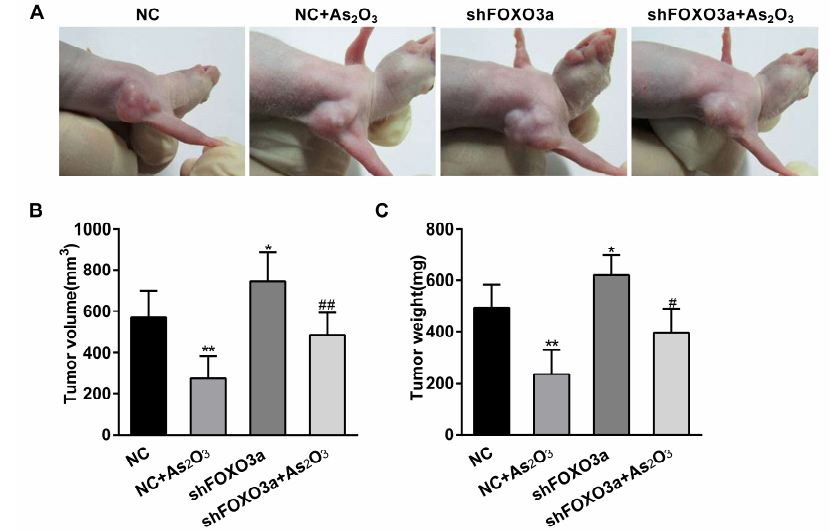
Figure 5. As 2 O 3 inhibited gastric tumor growth through regulating FOXO3a. ( A ) The xenografted tumors were formed by subcutaneous injection with shFOXO3a or negative control shRNA MGC-803 cells in nude mice. The tumors were observed after As 2 O 3 treatment. ( B , C ) The tumor volume and weight were respectively measured and statistically analyzed. Compared with the NC group, * p < 0.05, ** p < 0.01; compared with NC + As 2 O 3 group, # p < 0.05, ## p < 0.01.